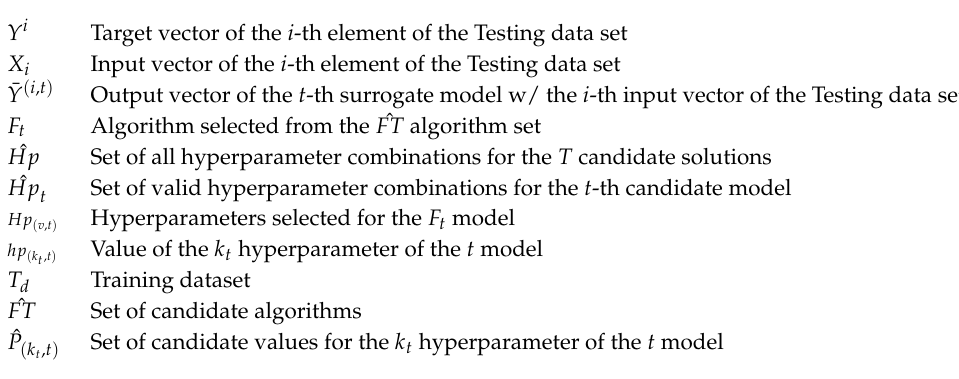
Algorithm selected from the ˆ FT algorithm